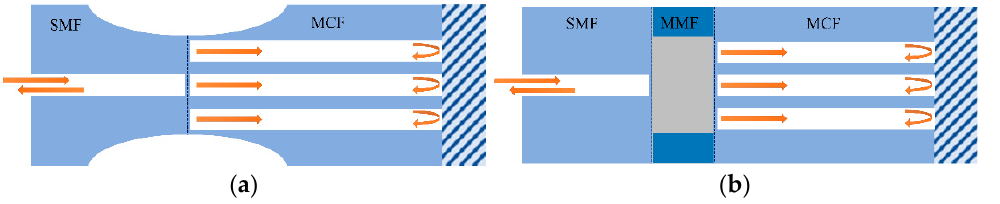
Figure 7. Schematics of typical coupling methods of the MCF ‐ based Michelson interferometer. ( a ) Tapering the MCFs at the fusing point, ( b ) fusing a segment of MMF between the SMF and MCFs.